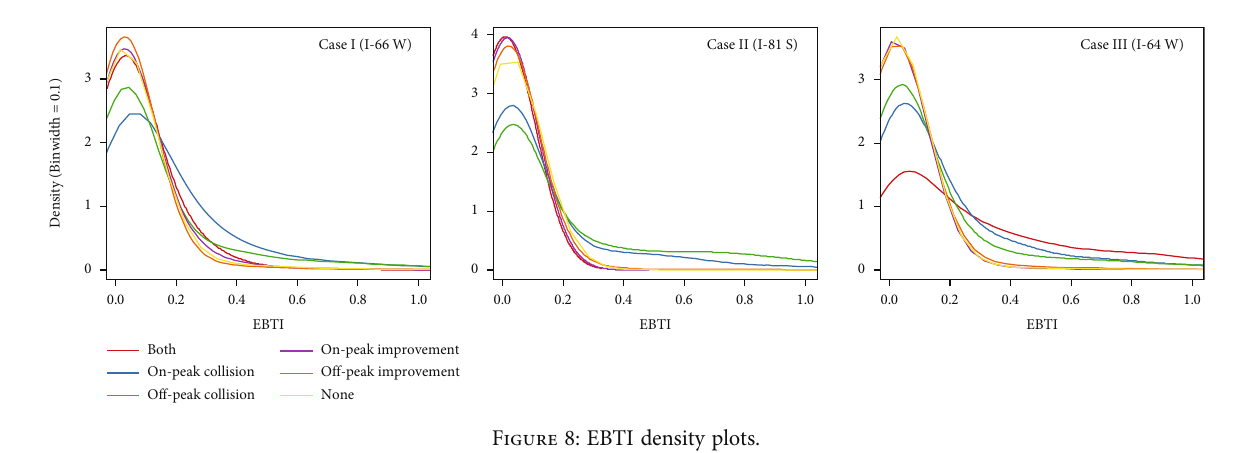
Figure 7: AvgR density plots.